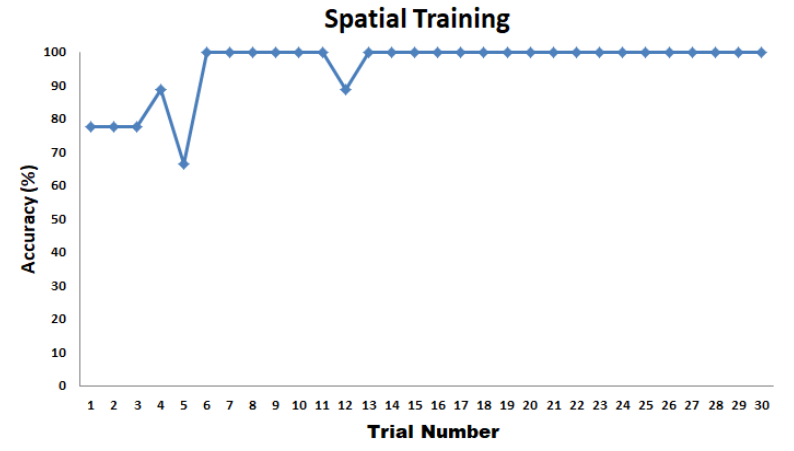
Figure 22. Spatial training